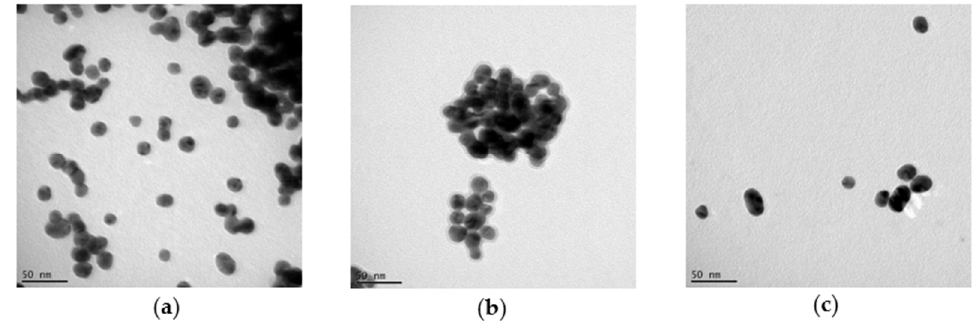
Figure 3. TEM images (scale bar = 50 nm) of bare AuNPs ( a ), AuNPs/VEGF Cys FAM ( b ) and AuNPs/VEGF Gly FAM ( c ). AuNPs/VEGF Gly FAM ( c ).